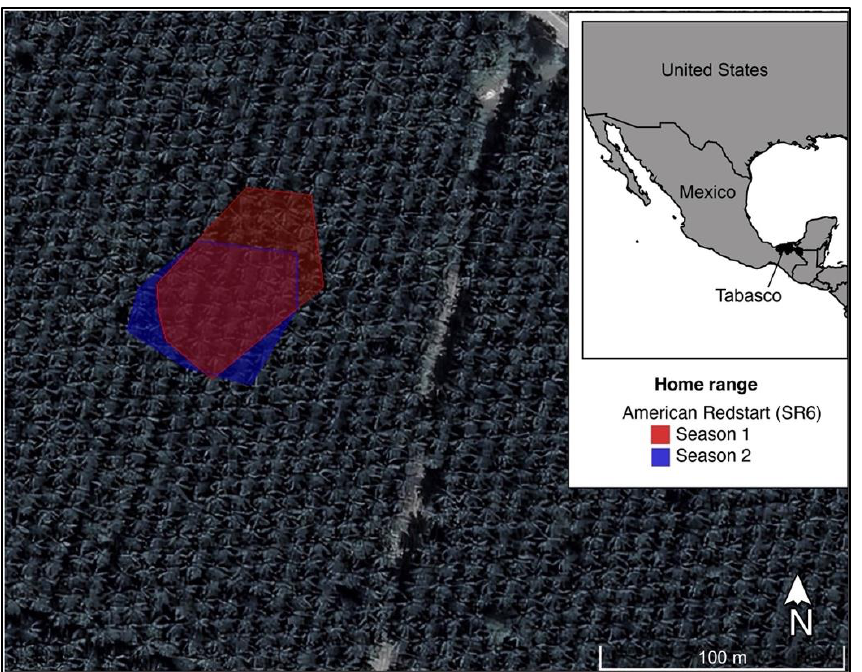
Figure 2. Pictures of the first year male American Redstart (SR6) captures in the first ( a ) and the second ( b ) wintering season, in oil palm plantations, Tabasco, Mexico.